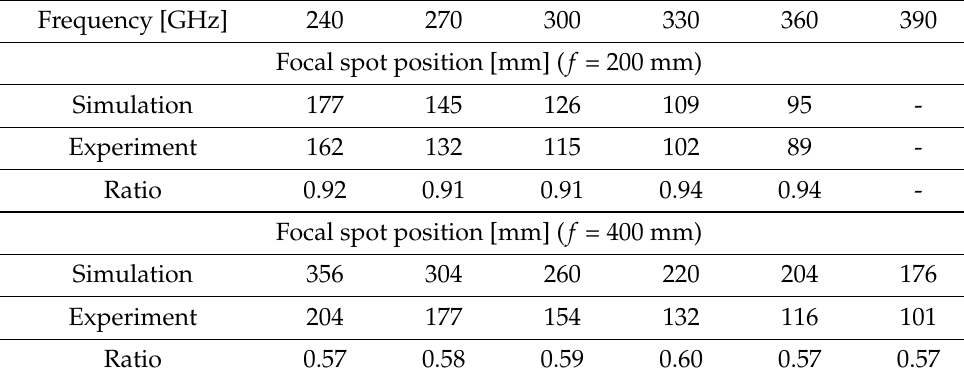
Table 1. Positions of shifted focal spots in the simulation and experiment for each DOE, corresponding to particular source frequencies. For each focal spot, the ratio between the calculated and measured shift value is